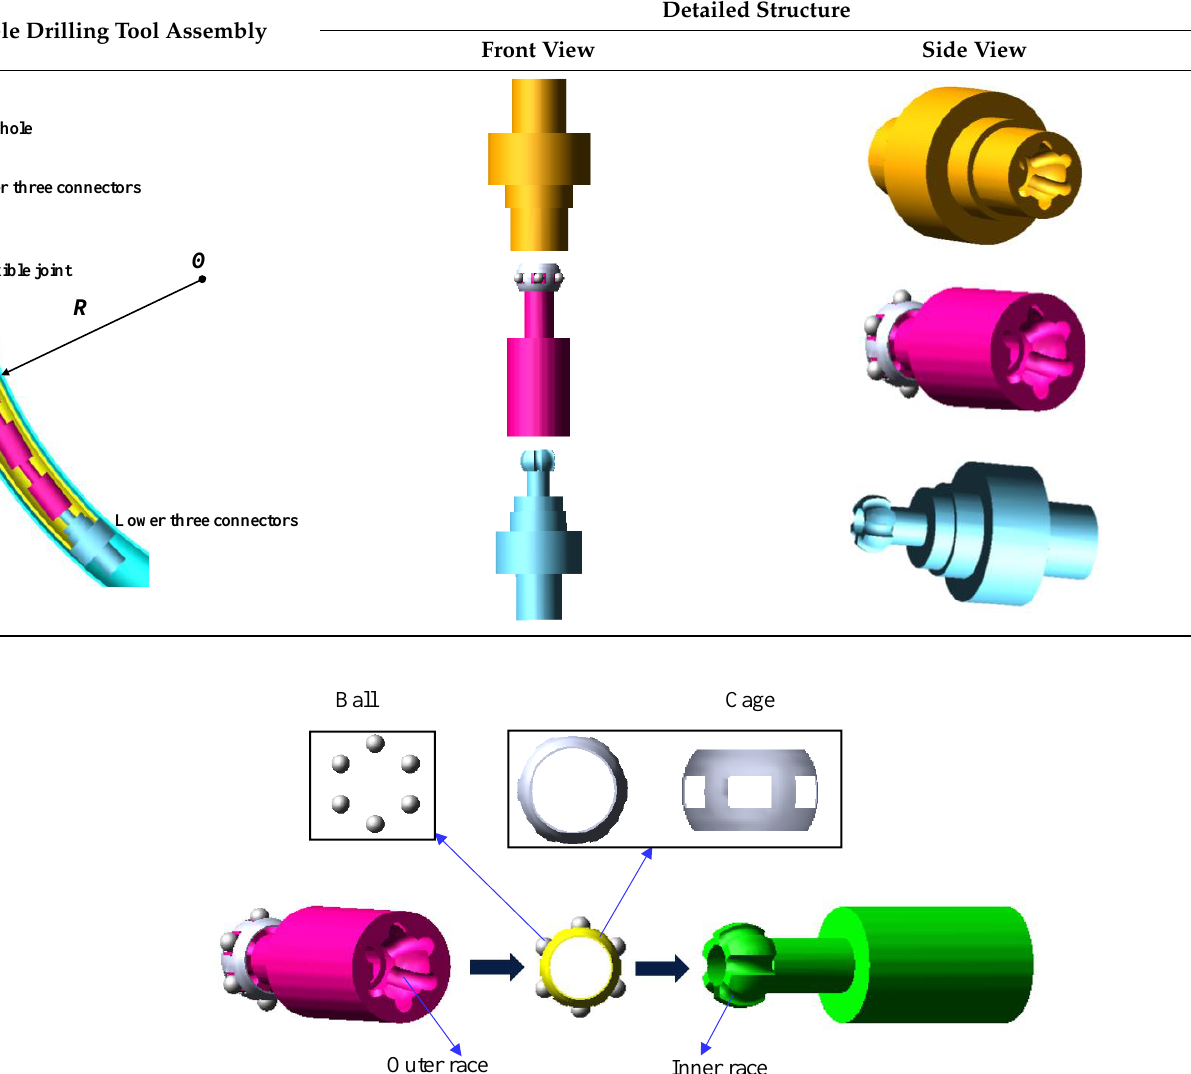
Table 1. Structure components of ball cage flexible drilling pipe.